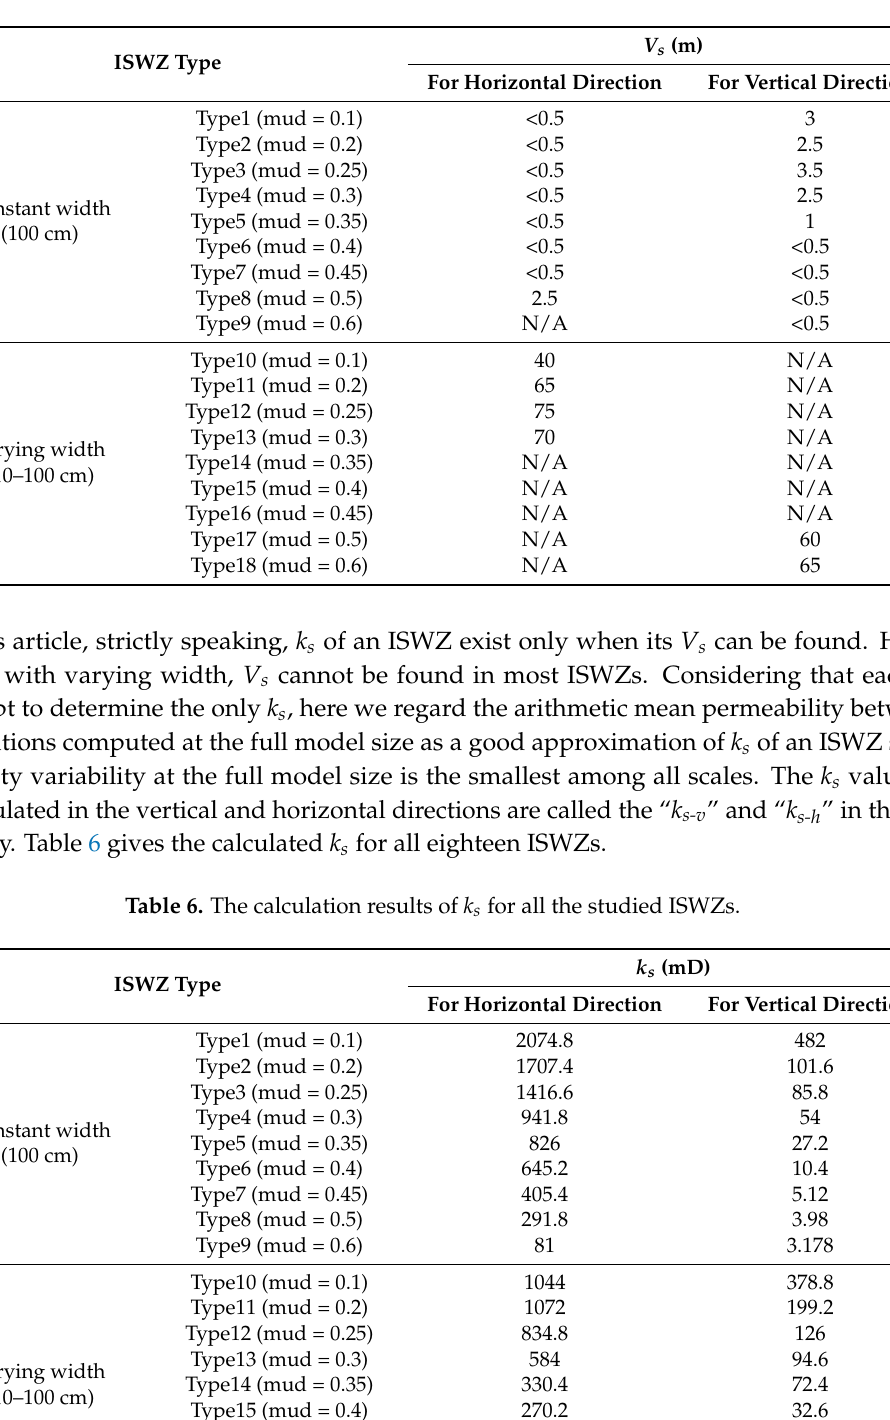
Table 5. The calculation results of V s for all the studied ISWZs.